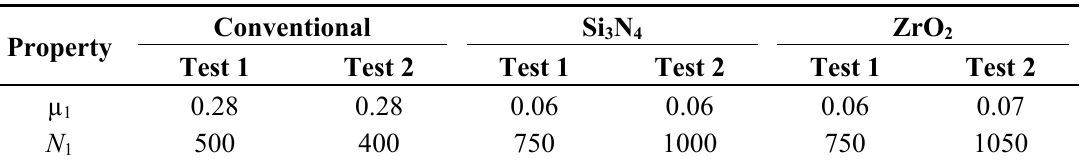
Table 2. The average friction coefficient of the steady-state sliding and the final cycle of a steady-state sliding. “Conventional” denotes AISI